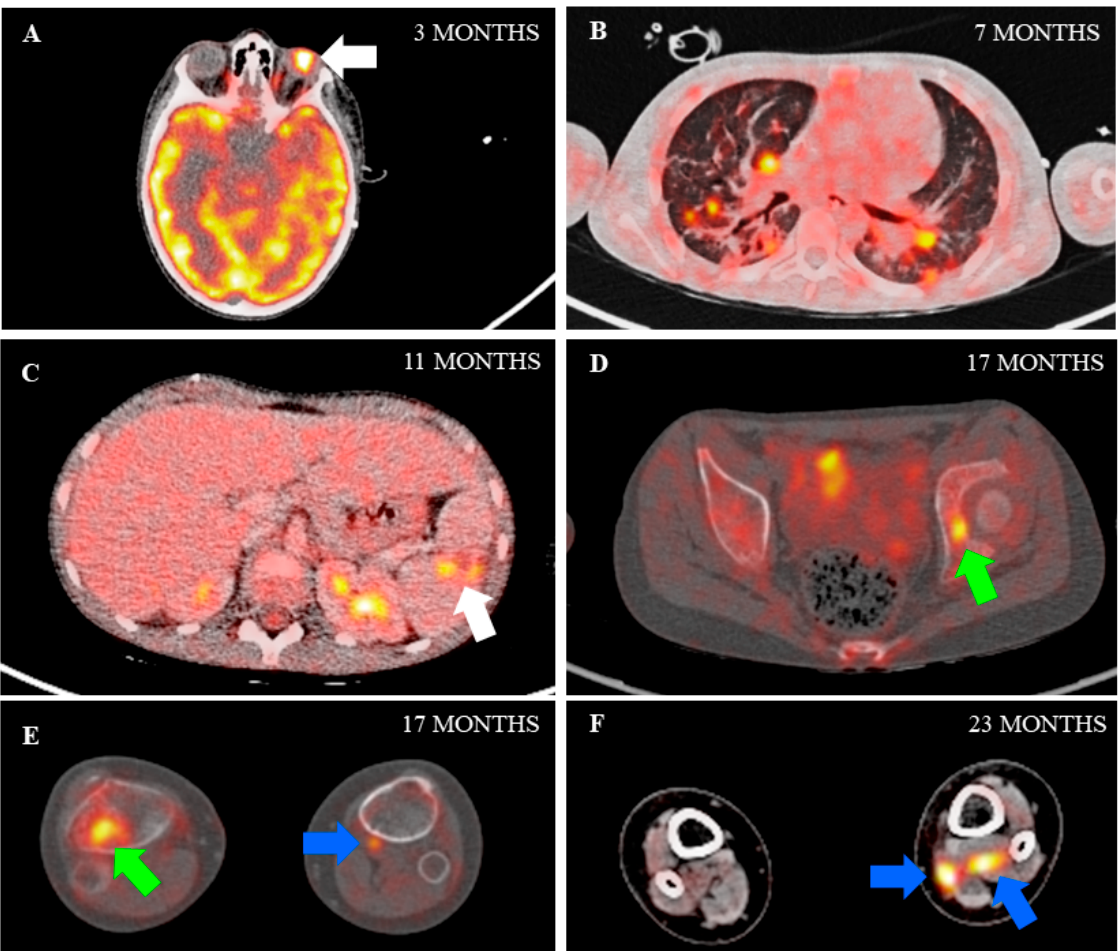
Figure 3. Fused fluorine-18 fluorodeoxyglucose positron emission tomography/CT ( 18 F-FDG PET/CT) images at various time points show pathological FDG uptake in the left eye (image ( A ); arrow), lungs (image ( B )), spleen (image ( C ); arrow), bone (images ( D , E ); green arrows) and muscles (images ( E , F ); blue arrows).